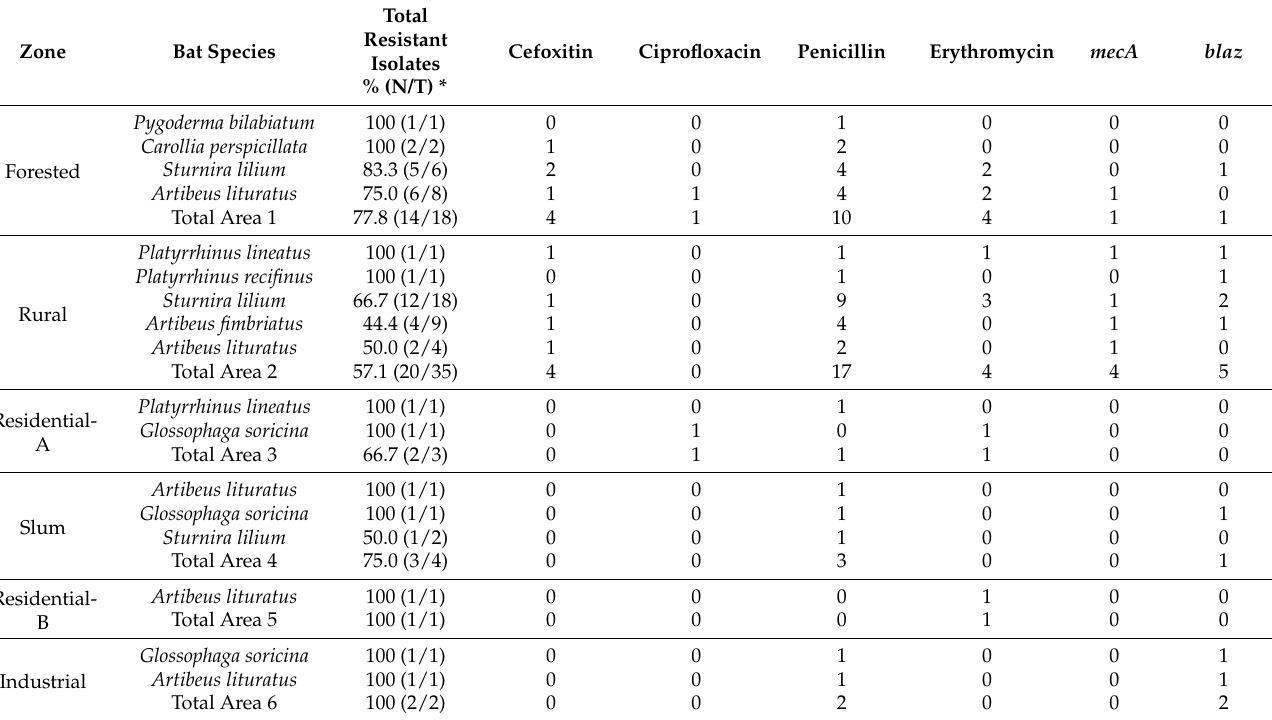
Table 2. Frequency of resistant Staphylococcaceae strains to cefoxitin, ciprofloxacin, penicillin, and erythromycin, and detection of mecA and blaZ genes according to the study zone. Zones are arranged from the lowest to the highest degree of anthropization.